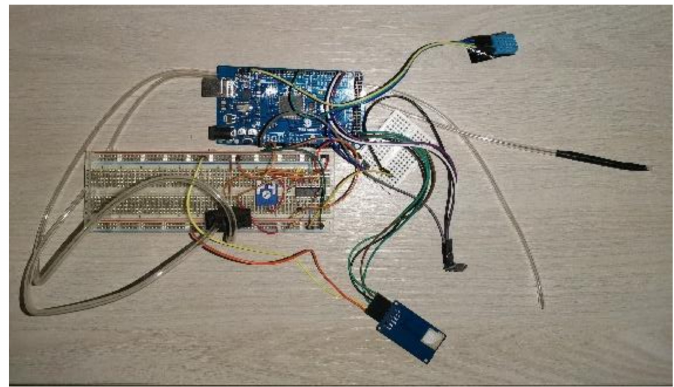
Figure 7. Prototype of the data-acquisition system.